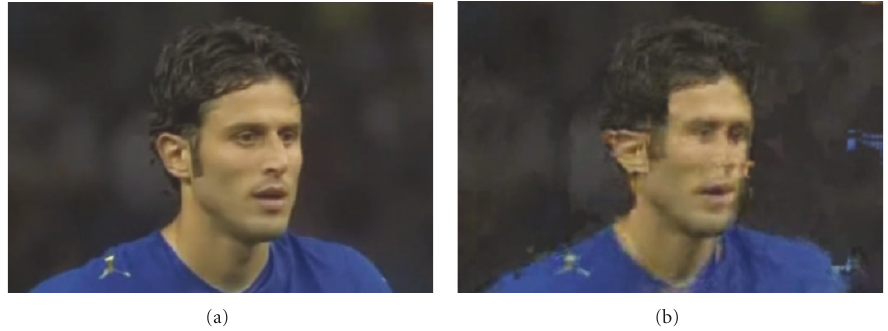
Figure 4: First scenario, multicast video streaming, SIR = 4 dB: (a) original frame, (b) corrupted